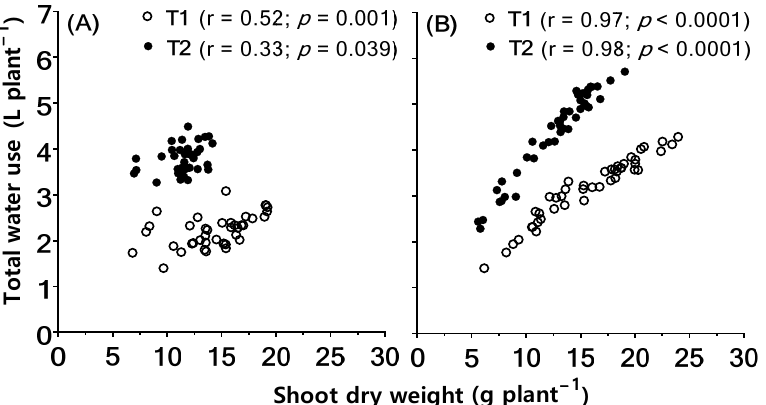
Figure 3. Relationship between shoot dry weight and total water use per plant during the period of temperature treatment in Batch 01 ( A ) and Batch 02 ( B ) wheat genotypes under T1 and T2 temperature conditions. Each data point represents an individual plant (replicate), all genotypes combined. Pearson correlation coefficient (r) and probability ( p ) are given in each sub-figure.